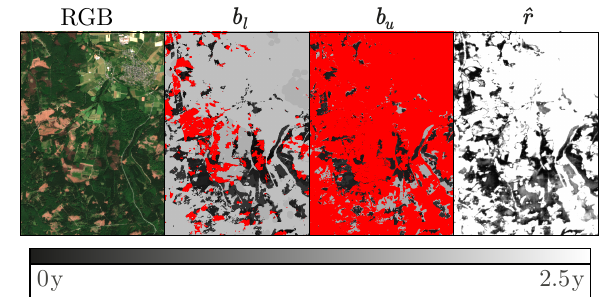
Figure 4. Example for an image in the test region (RGB), corresponding interval limits b l , b u and predictions ˆ r of the regression model. The grey values indicate the RLT. Red areas correspond to unknown